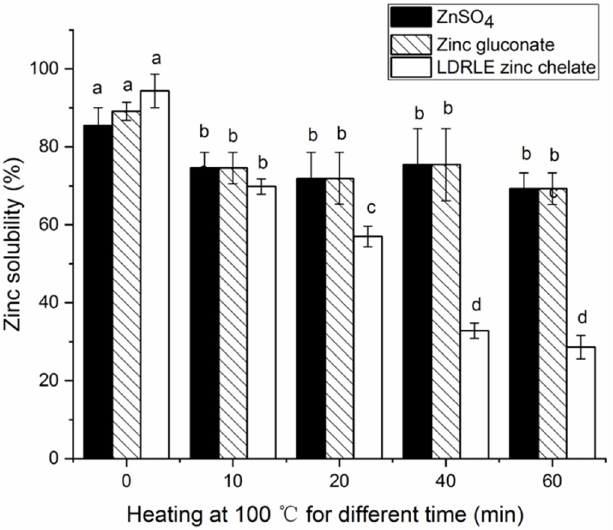
Figure 7. Zinc solubility stability of LDRLE-zinc chelate, zinc sulphate and zinc gluconate against incubation at 100 °C for 10–60 min. Different lowercase letters (a–d) above the bars or near the lines indicate significant differences ( p < 0.05).